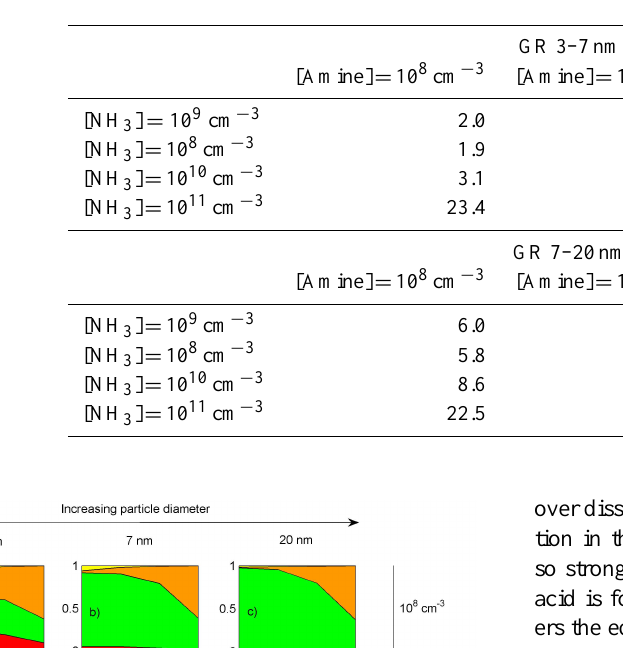
Table 3. Growth rates of 3–7nm and 7–20nm particles calculated based on the dry size for three amine concentrations when concentration of NH 3 was varied from the base case (10 9 cm − 3 , first row). Organic acid concentration and saturation vapour pressure were 3 × 10 8 cm − 3 and 10 − 6 Pa. Sulfuric acid concentration (10 6 cm − 3 ) , RH (40%) and temperature (283.15K) were set to base case values in all simulations (Table 2).